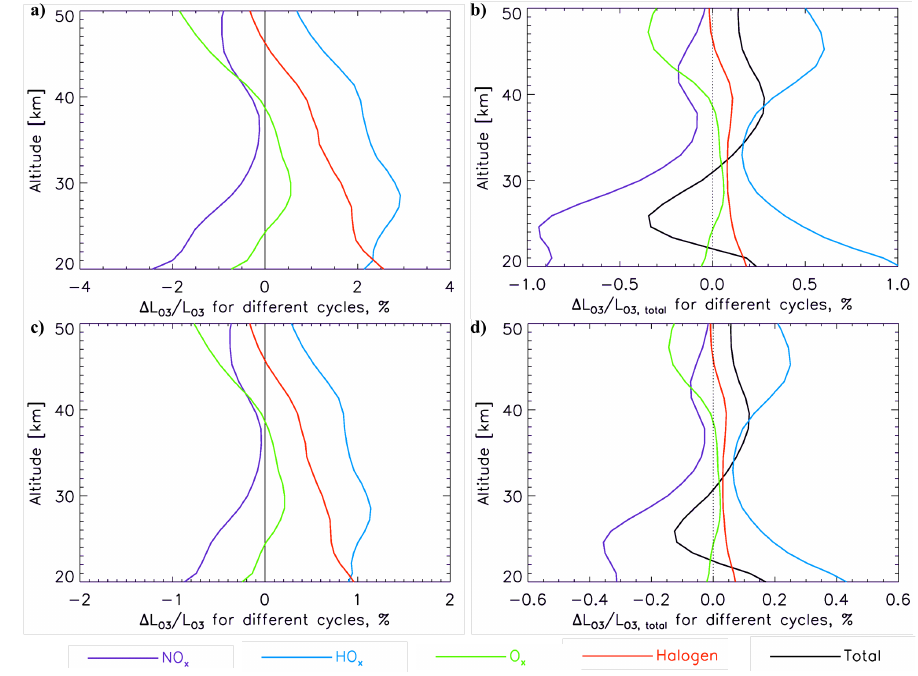
Figure 6. Changes in contributions of different catalytic O 3 destruction cycles to the total O 3 loss in the H 2 -FC scenarios compared to the baseline scenario. Panels (a) and (b) are for A1FI and panels (c) and (d) are for B1. (a) and (c) % change in contribution of each catalytic cycle compared to its contribution in the BL; (b) and (d) % change in contributions of different catalytic O 3 destruction cycles compared to the total O 3 loss rate in BL. All figures are daily averaged values for the September equinox at 35 ◦ N.